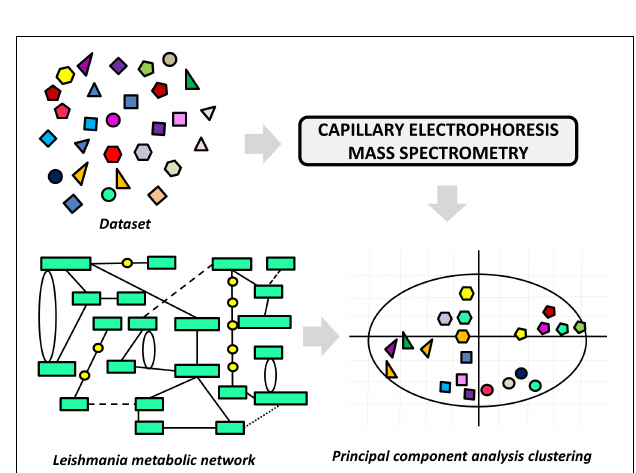
FIGURE 5 | Structure-based virtual screening that resulted in the first report of a series of non-covalent L. major tryparedoxin peroxidase I inhibitors. The molecular docking approach led to the identification of aliphatic adamantyl derivative 11 which shows suitable activity against the enzyme.